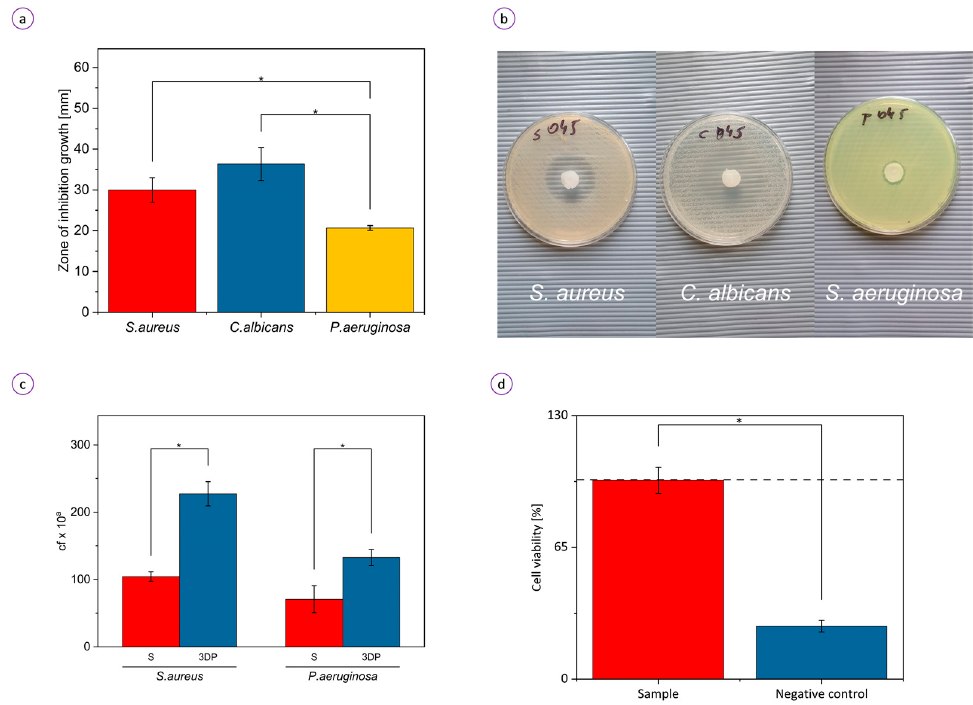
Figure 6. Biological activity of the hydrogel: ( a ) average diameter of inhibition zones of S. aureus, C. albicans, and P. aeruginosa and ( b ) corresponding photos of the dishes; ( c ) ability of S. aureus and P. aeruginosa to colonize the molded (S) and 3D-printed (3DP) hydrogel samples. An exponent “a” corresponds to 9 and 6 for S. aureus and P. aeruginosa , respectively; “cf” means colony-forming; ( d ) viability of fibroblasts exposed to medium conditioned with extracts from the analyzed sample and ethanol (negative control). Absorbance at 490 nm measured for unexposed fibroblasts (C) was considered 100% (black dashed line); * p < 0.05.